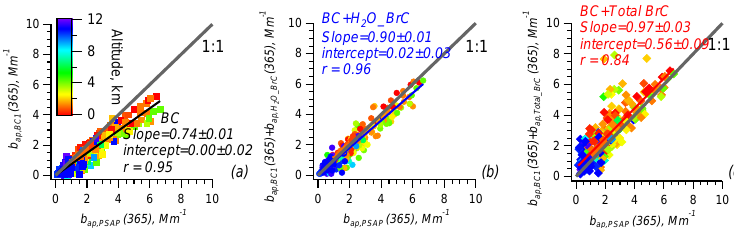
Figure 8. Closure analysis of b ap at 365nm for background tropospheric conditions. Scatter plots of estimated (a) BC absorption, (b) sum of BC absorption and water-soluble BrC absorption, and (c) sum of BC absorption and total BrC absorption, compared with total aerosol absorption estimated by PSAP. Markers are color-coded by altitude. Orthogonal distance regression (ODR) fit results are shown. The 1 : 1 line is also included. (Measurement uncertainties of the various absorption coefficients are estimated to be between ± 28 and ± 45%.)